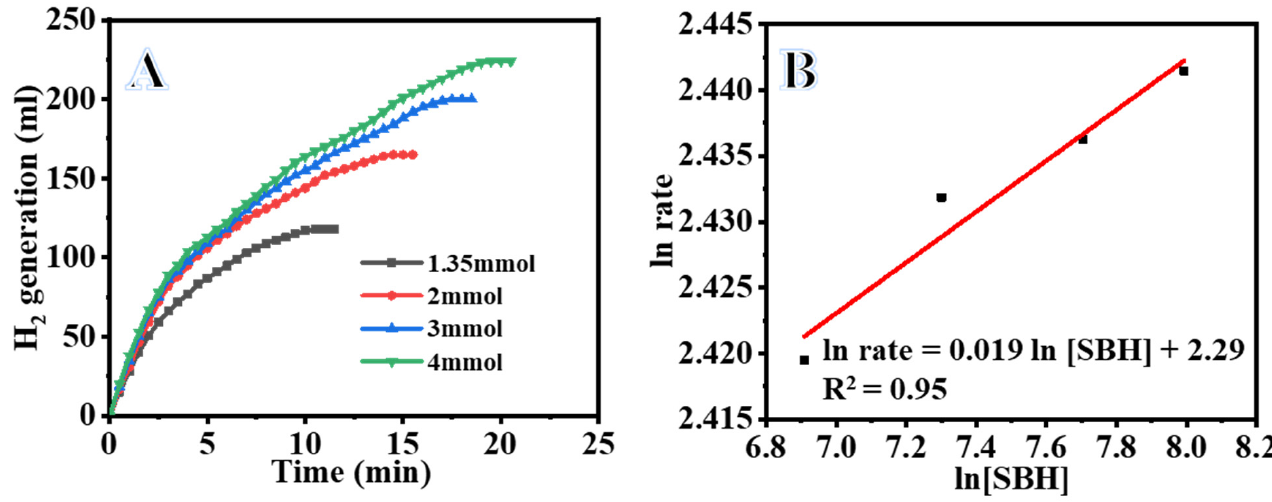
Figure 8. Effect of [SBH] on H 2 evolution ( A ) and log of the H 2 generation vs. log [SBH] ( B ). [Quantity of catalyst = 100 mg of Ni 0.3 Co 0.7 @PVDF ‐ HFP NFs membrane and T = 298 K].